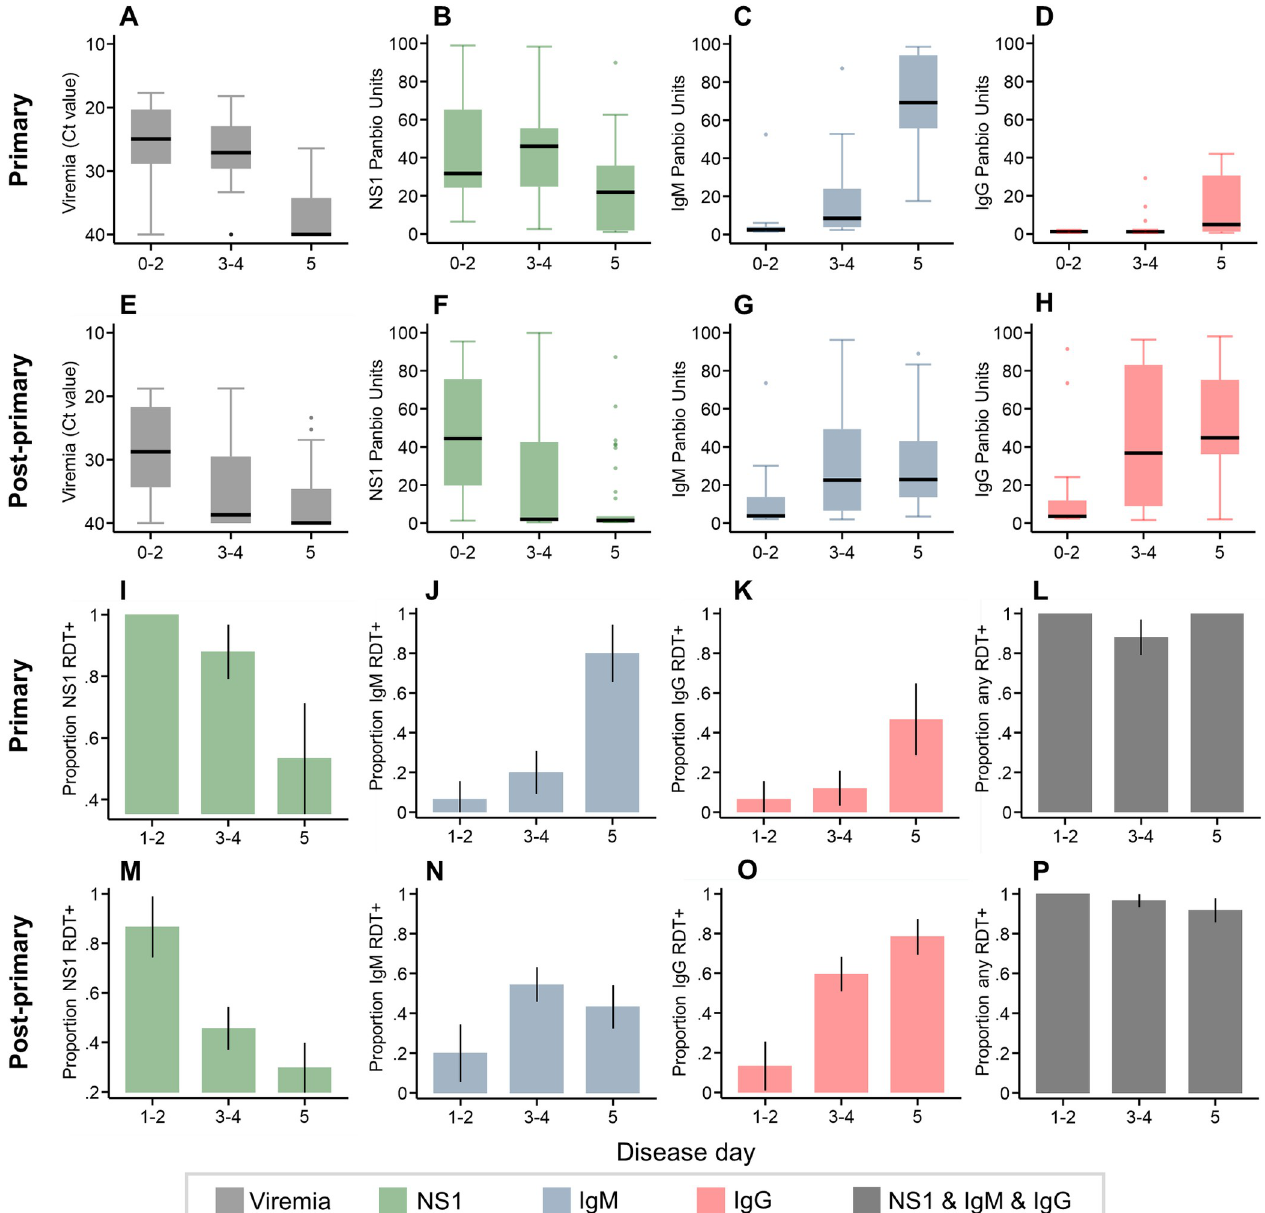
Fig 1. Infection kinetics among primary and post-primary DENV patients from Indonesia by disease day according to laboratory and rapid tests. A-H: Boxplots of viremia (Ct), NS1, IgM and IgG by disease day among primary and post-primary cases according to PCR and ELISA tests. I-P : Proportion RDT positive to NS1, IgM, IgG and all combined by disease day among primary and post-primary cases. Black error bars: 90% confidence intervals based on t- distributions. (Primary N: 55) (Post-primary N:109).